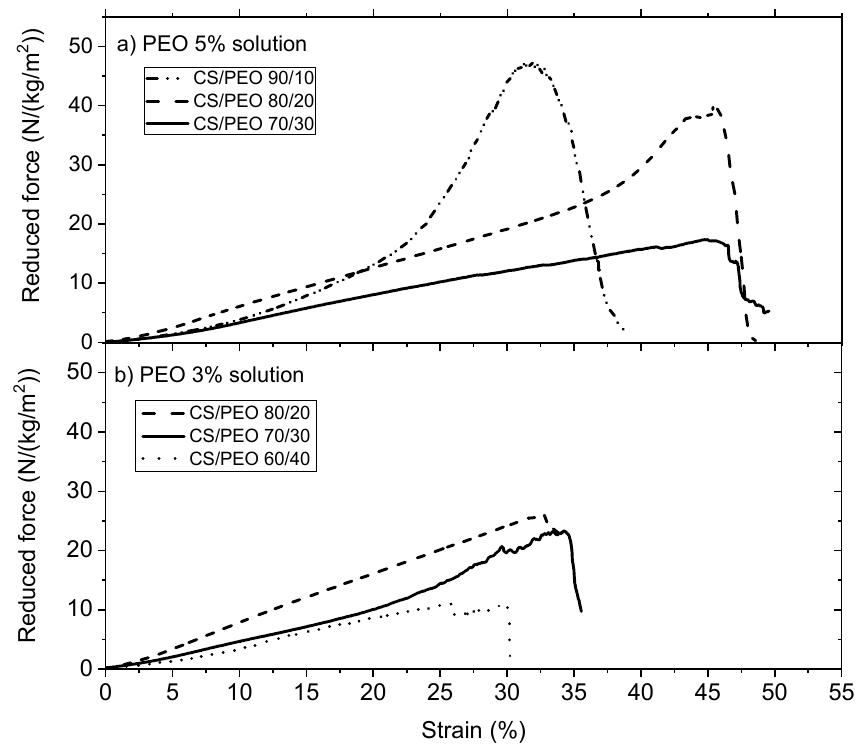
Figure 8. Uniaxial extension for chitosan nanofibers in the wet state after PEO extraction ( a ) PEO mixed in solution from M W = 5 × 10 6 at 5% ( b ) PEO mixed in solution from PEO 5 × 10 6 solution at 3%.